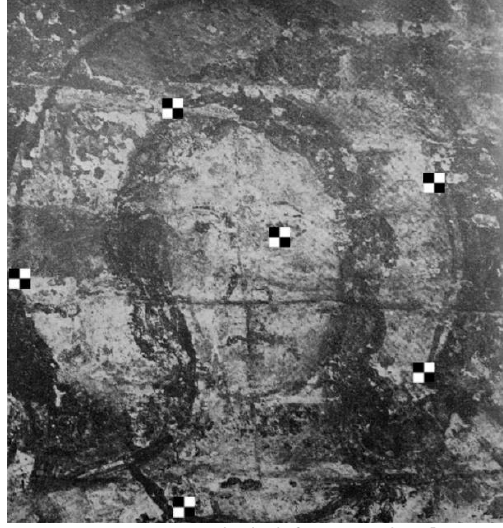
Figure 9. Tie points on high-definition archival image.